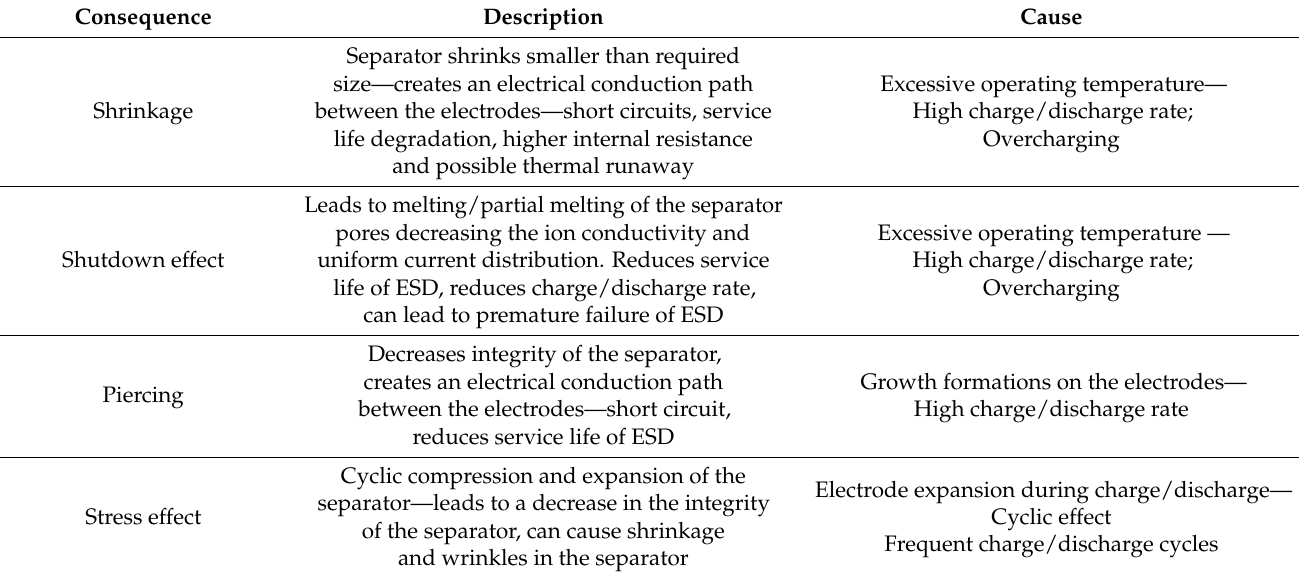
Table 9. Causes of degradation in ESD separators, adapted from